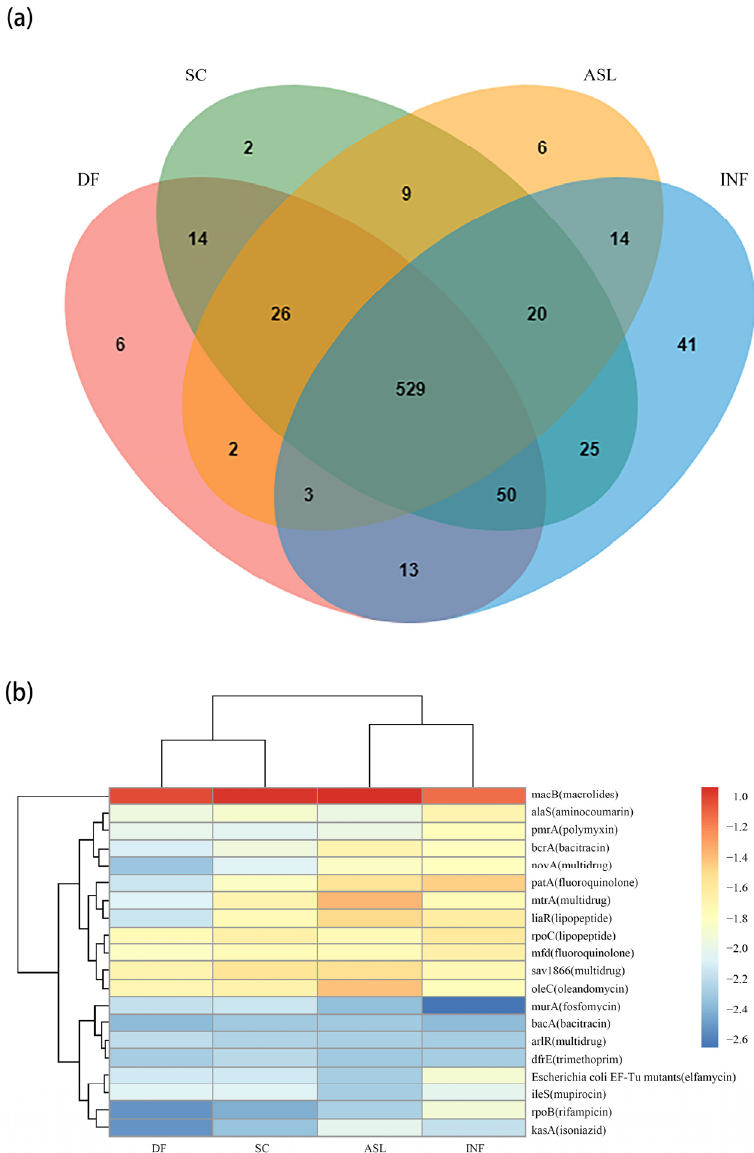
Figure 2. Distribution of ARG subtypes in different samples. ( a ) Distribution of ARG subtypes in INF, ASL, SC, and DF; ( b ) the top 20 abundant ARG subtypes are based on the RPKM method (the color bar indicates log10-transformed values of relative abundance).